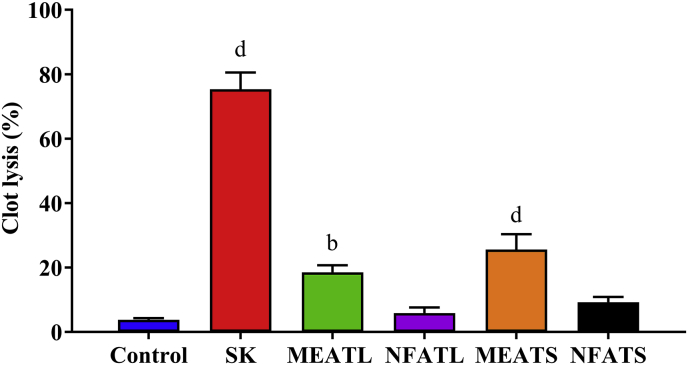
Percentage of clot lysis of human blood by A. trilobata fractions and standard drug. Values are represented in Mean ± SEM (n = 6). b P < 0.01 and d P < 0.0001 are statistically significant in comparison to negative control (water) followed by unpaired t-test of one-way ANOVA (GraphPad Prism 7). SK: streptokinase, MEATL: Methanolic extract of A. trilobata leaves, NFATL: n-hexane fraction of A. trilobata leaves, MEATS: Methanolic extract of A. trilobata stem and NFATS: n-hexane fraction of A. trilobata stem.